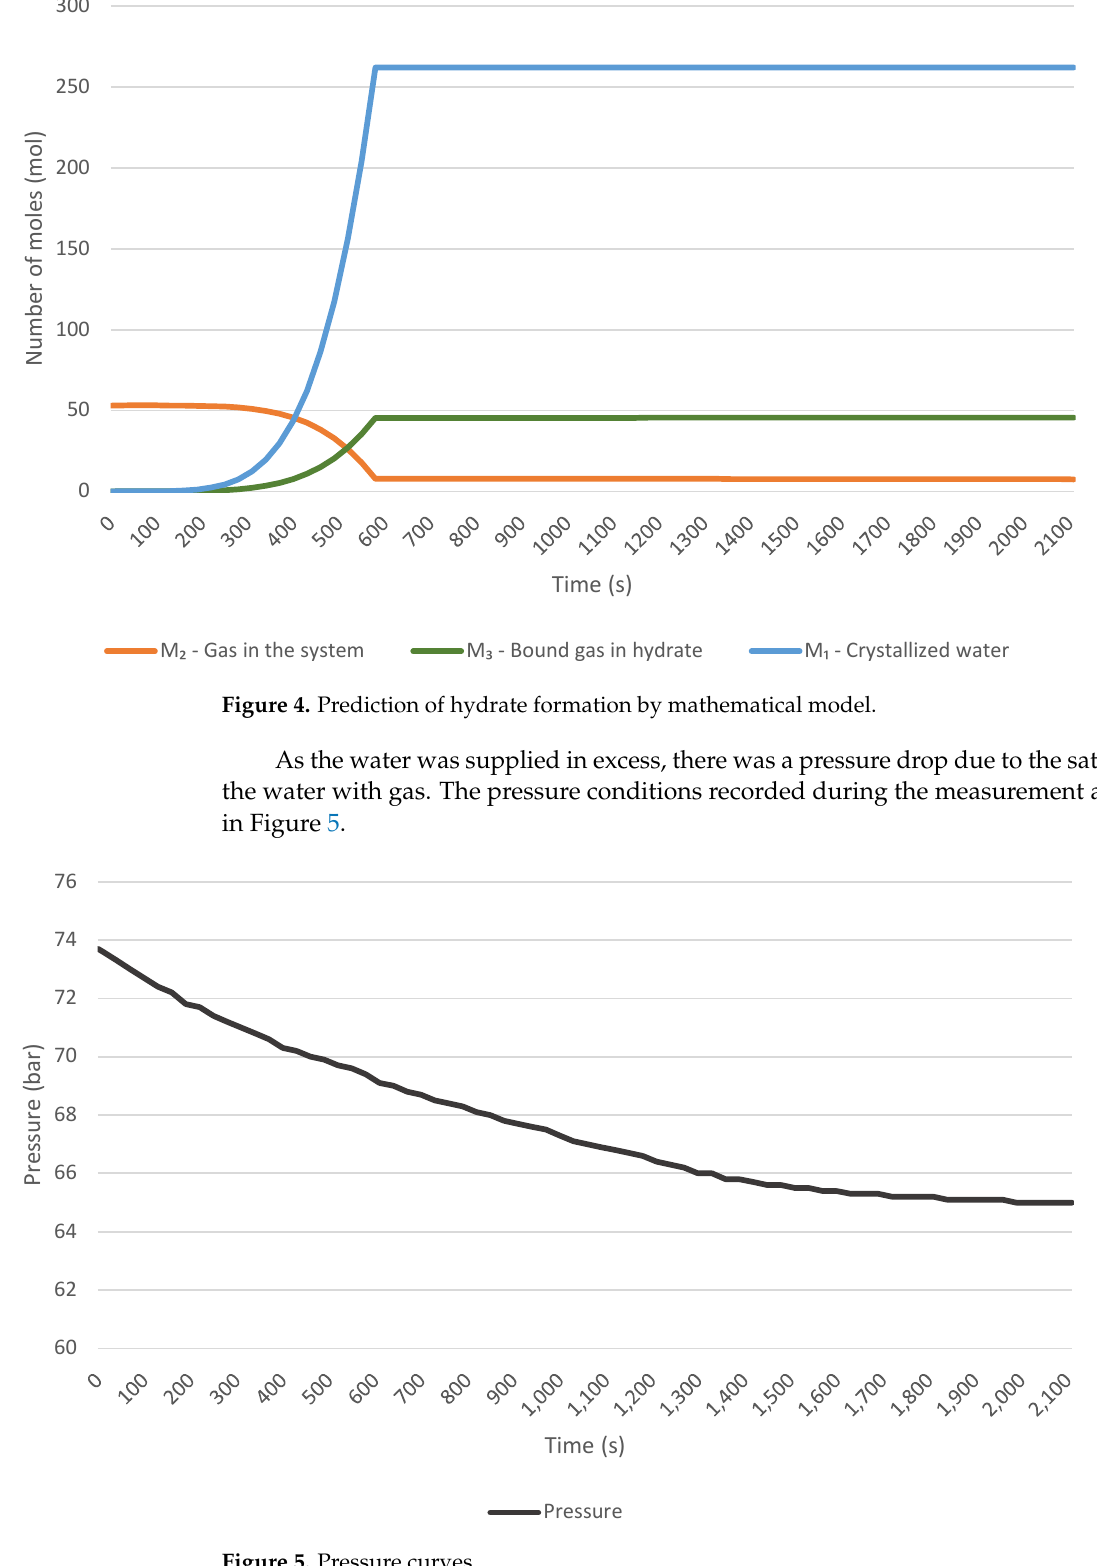
Figure 5. Pressure Figure 5. Pressure curves.